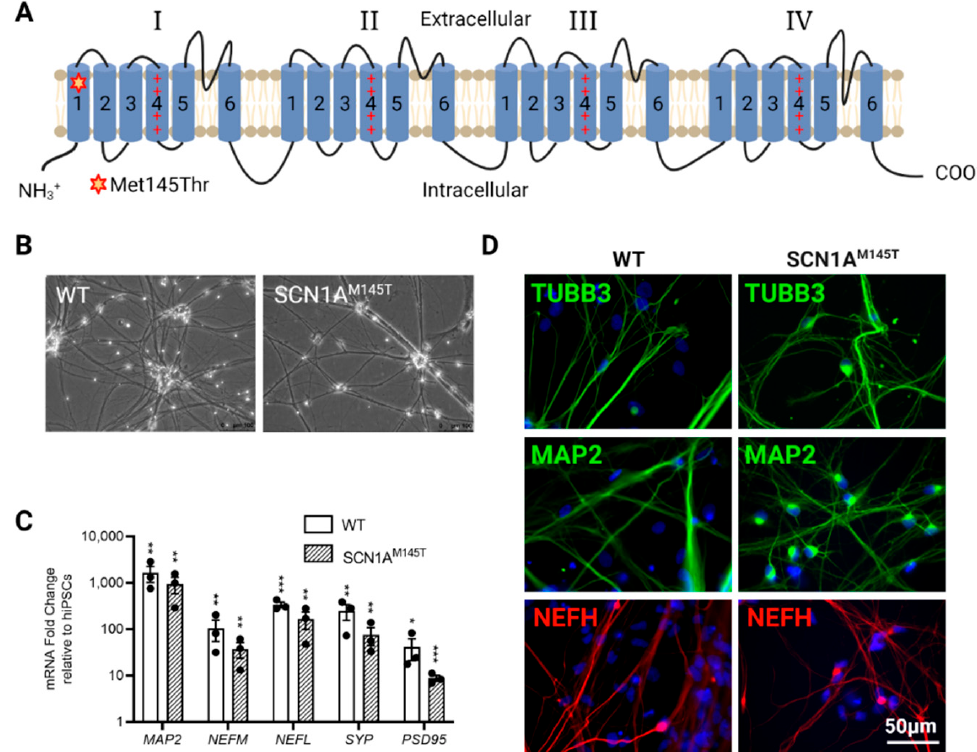
Figure 1. Characterization of idNs. ( A ) Representation of Na V 1.1 channel. The star in segment 1 of domain I shows the localization of the mutated aminoacid (Met145Thr). The relative missense mutation c.434T > C is found in the exon 3 of the translated sequence. ( B ) Bright-field images of idNs from WT and SCN1A M145T -iPSCs (20 × magnification). ( C ) Differentiated idNs show high expression levels of neuronal specific genes such as MAP2 , NEFM , NEFL, SYP and PSD95 compared to their undifferentiated counterparts (iPSCs). GAPDH was used as a housekeeping control. Data are presented as mean ± SEM of three biological replicates (black dots), * p < 0.05, ** p < 0.01, *** p < 0.001, t -test has been calculated vs. expression in iPSCs. ( D ) Immunostaining of neuronal markers TUBB3 (neurites marker), MAP2 (cell body and dendrites marker), and NEFH (axonal marker) in WT and SCN1A M145T idNs. DAPI nuclear counterstain is shown in all images in blue (63 × magnification). Morphological analysis of cultured idNs revealed the presence of both bipolar (in- hibitory) and pyramidal (excitatory) populations (Figure 2A). The expression of glutamate decarboxylase ( GAD2 , GABAergic marker) and vesicular glutamate transporter (v GLUT2 , glutamatergic marker) by qRT-PCR analysis revealed a slightly higher expression of the GABAergic marker in idNs from WT and SCN1A M145T (Figure 2B). In addition, by im- munofluorescence analysis, we found that about 90% of MAP2 + neurons indeed co-express the GABAergic marker GAD1 (Figure 2C,D). On the other hand, the glutamatergic marker vGLUT1 could be slightly detected in few cells only (Supplementary Figure